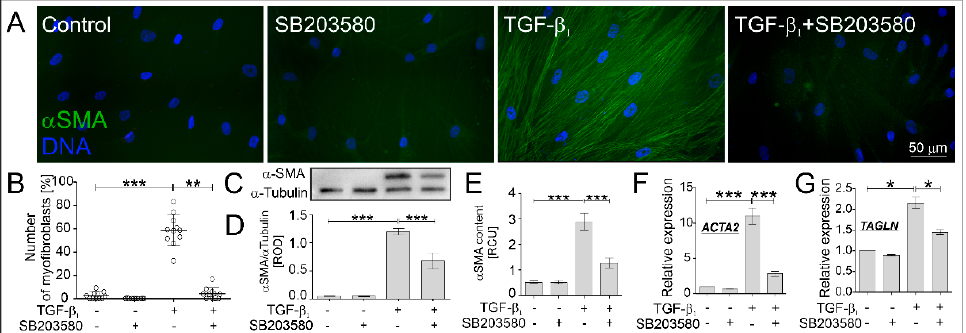
Figure 2. The TGF- β 1 -induced FMT of HBFs AS is significantly inhibited by SB203580. The ef- ficiency of the FMT was checked in HBF AS populations cultured without or with SB203580 (10 µ M) in the absence or presence of TGF- β 1 (5 ng/mL) for five days. ( A ) Representative im- ages of HBFs AS, immunostained for α -SMA (green) and counterstained for DNA (blue), were obtained. Scale bar = 50 µ m. ( B ) The percentage of myofibroblasts in HBF AS cultures ( n = 11) are presented on the graph. The level of α -SMA in HBFs AS ( n = 3) was determined using ( C , D ) Western blot and ( E ) in-cell ELISA. RCU—relative colorimetric units. ( F , G ) Relative expression levels of myofibroblast-related genes: ACTA2 (encoding α -SMA), TAGLN (encoding transgelin) in HBFs AS ( n = 4) cultured for 24 h in conditions described above were presented as a 2 − ∆∆ Ct mean value in relation to control genes ( 18S , B2M and GAPDH ) and control conditions. Statistical significance was tested using the non-parametric Kruskal–Wallis test with Dunn’s Multiple Comparison post hoc test; * p < 0.05; ** p < 0.01; *** p <